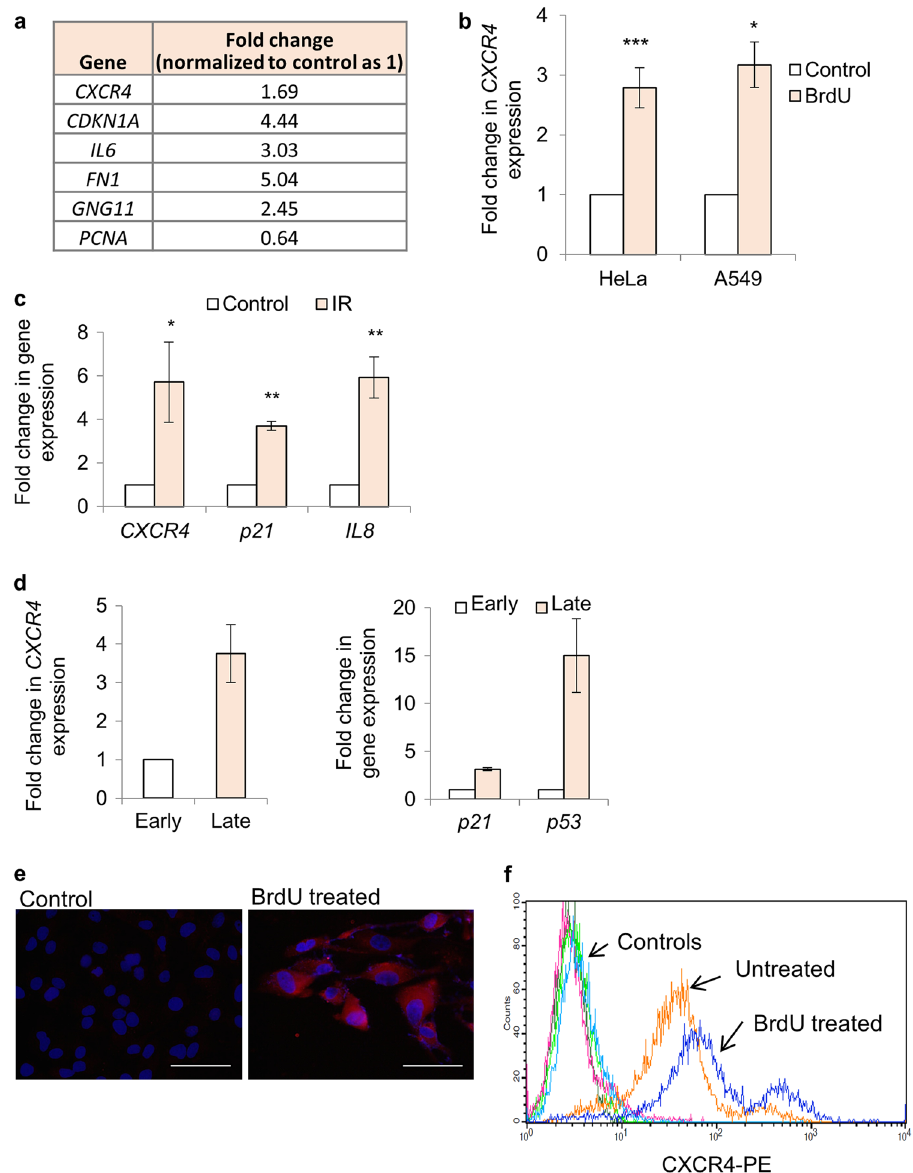
Fig. 1 CXCR4 expression analysis in response to DNA damage. a Gene expression changes after BrdU treatment in HeLa cells. Expression pattern of genes as indicated after 48 h of BrdU treatment (100 μ M) by microarray analysis. Data extracted from the microarray experiment is reported in Supplementary Fig. S1a ( n = 2). The numbers indicate fold change in gene expression during BrdU treatment wrt Control (normalized as 1). b CXCR4 gene expression analysis after DNA damage. HeLa and A549 cells were treated for 48 h with 100 μ M BrdU followed by qRT-PCR analysis of CXCR4 expression. The values were normalized to β -actin expression and then wrt control cells to calculate fold changes. Results shown are mean ± s.e.m. * p ≤ 0.05; *** p ≤ 0.001 (Student ’ s t -test; n > 3). c Gene expression analysis during IR-mediated DNA damage. Expression analysis of CXCR4, p21 , and IL8 after irradiation of HF-hTERT cells using qRT-PCR. The values were normalized to β -actin expression and then wrt control cells to calculate fold changes. Results shown are mean ± s.e.m. * p ≤ 0.05; ** p ≤ 0.01 (Student ’ s t -test; n > 3). d Gene expression analysis during replicative exhaustion mediated DNA damage and senescence. Expression analysis of CXCR4 (left) and DDR genes P21 and P53 (right) in early (20 PDL) and late (40 PDL) passage MRC5 cells by qRT-PCR. The values were normalized to β -actin expression and then wrt control cells to calculate fold changes ( n = 2). e Immuno fl uorescence and f surface expression analysis of CXCR4 receptor by fl ow cytometry. HeLa cells were probed for CXCR4 expression as per the protocol described in Materials and methods section. (magni fi cation 40×; scale bar = 40 µm; n = 5 for e and n = 3 for f